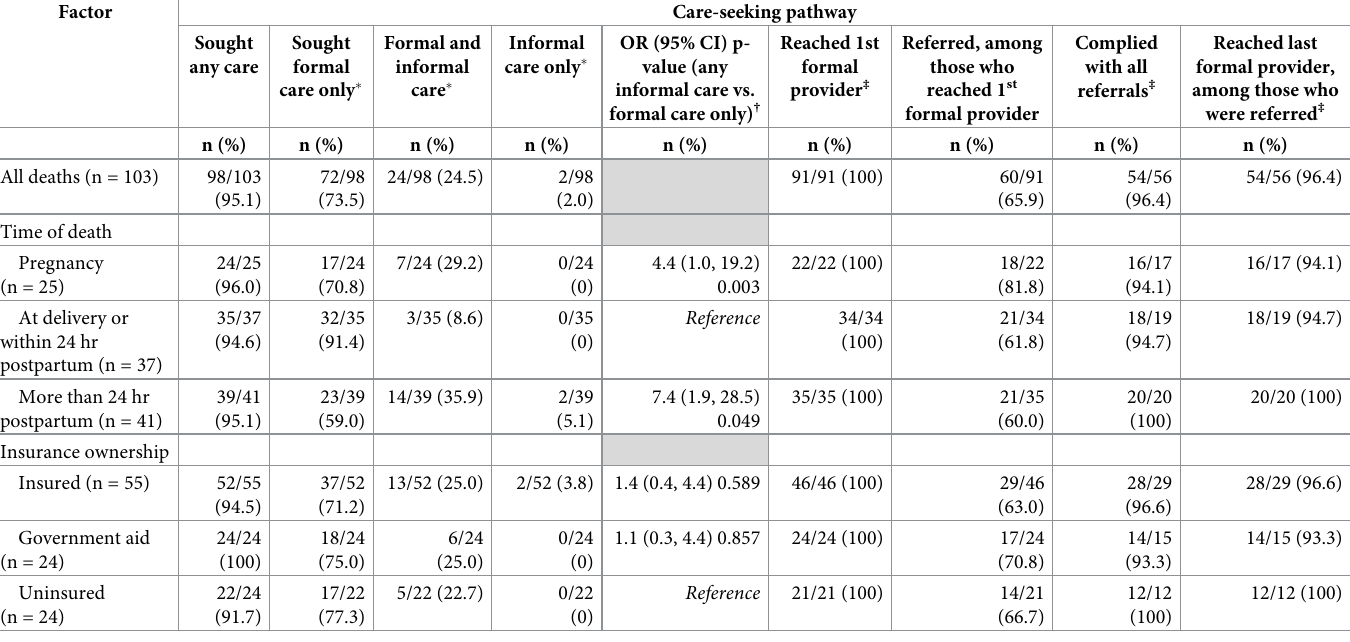
Table 2. Summary of care-seeking pathways by time of death and insurance in Jember District,